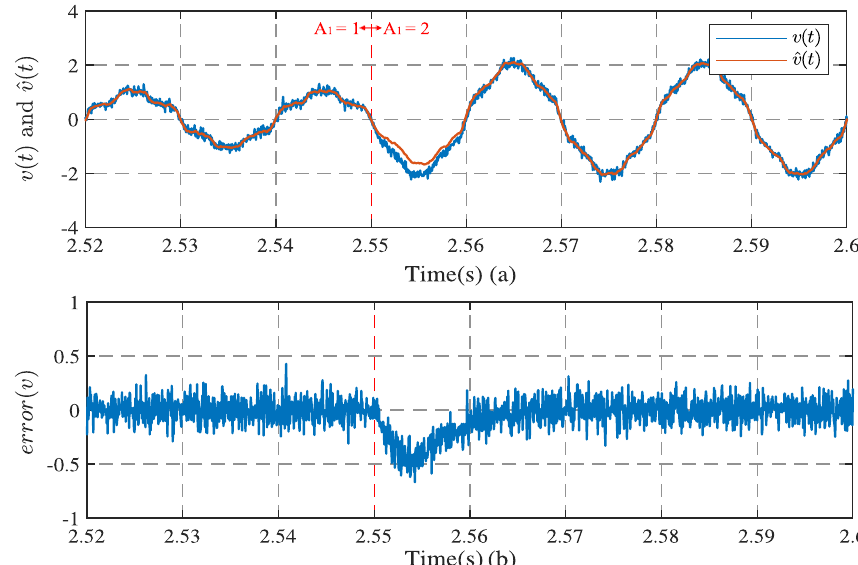
Figure 9. Tracking of the input signal and error by the system after adding white noise: ( a ) Tracking of the input signal and; ( b ) error.